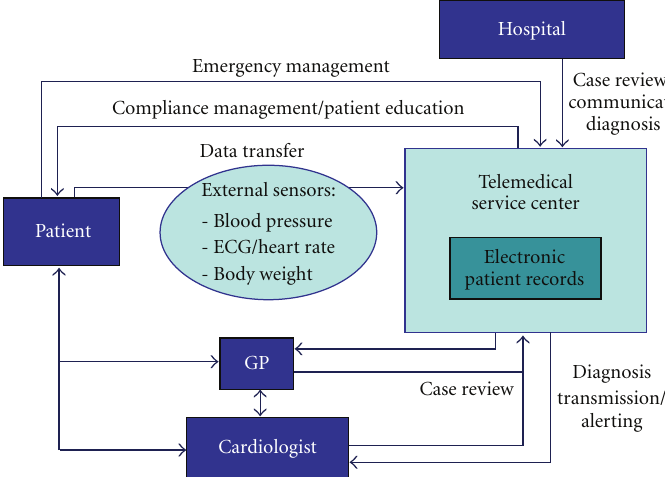
Figure 1: Overview of a complex telemedical support system for patients with chronic heart